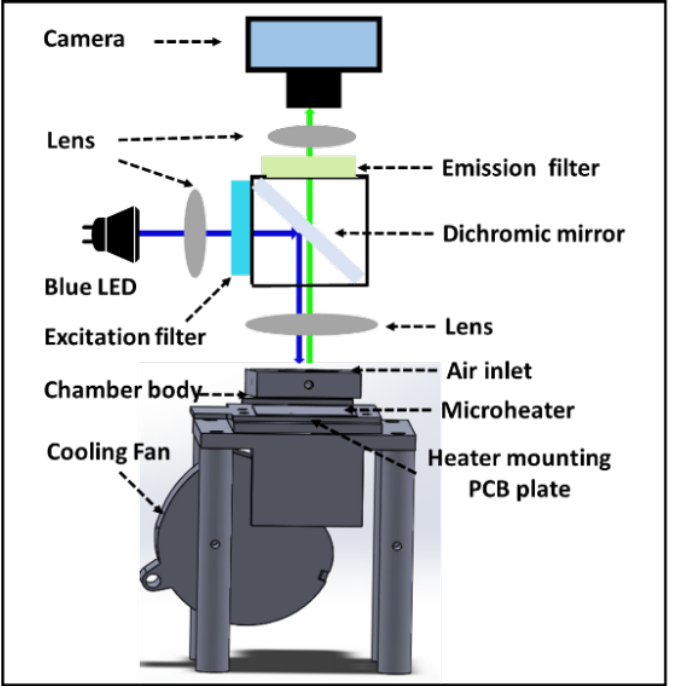
Figure 2. Schematic diagram of detection light path and high-pressure thermal cycling device.